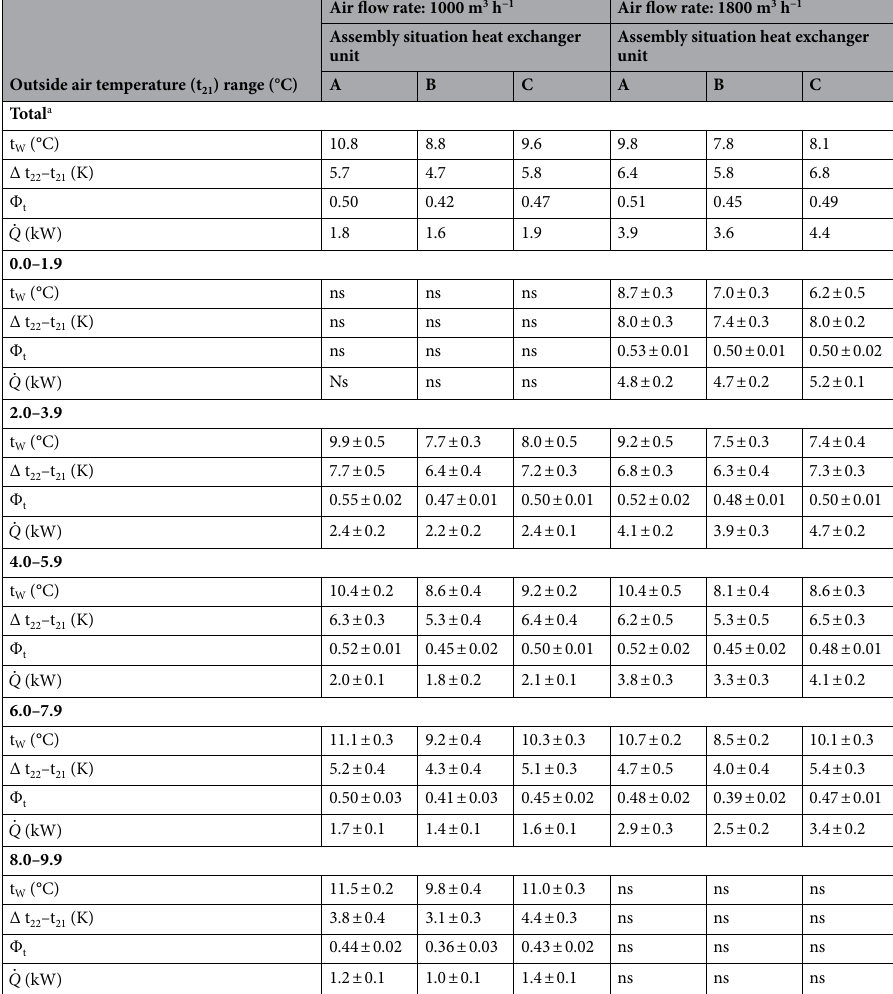
Table 1. Performance comparison of the exchange scrubber pilot-plant for the three assembly situations of heat exchanger unit and air flow rates of 1000 m 3 h −1 and 1800 m 3 h −1 by stating the core values (mean ± standard deviation): scrubbing water temperature, t W ; outside air preheating, Δ t 22 –t 21 ; temperature ˙ Q efficiency, Φ t ; heating performance, ; ns = not specified. a Weighted average. For variants with air flow rate